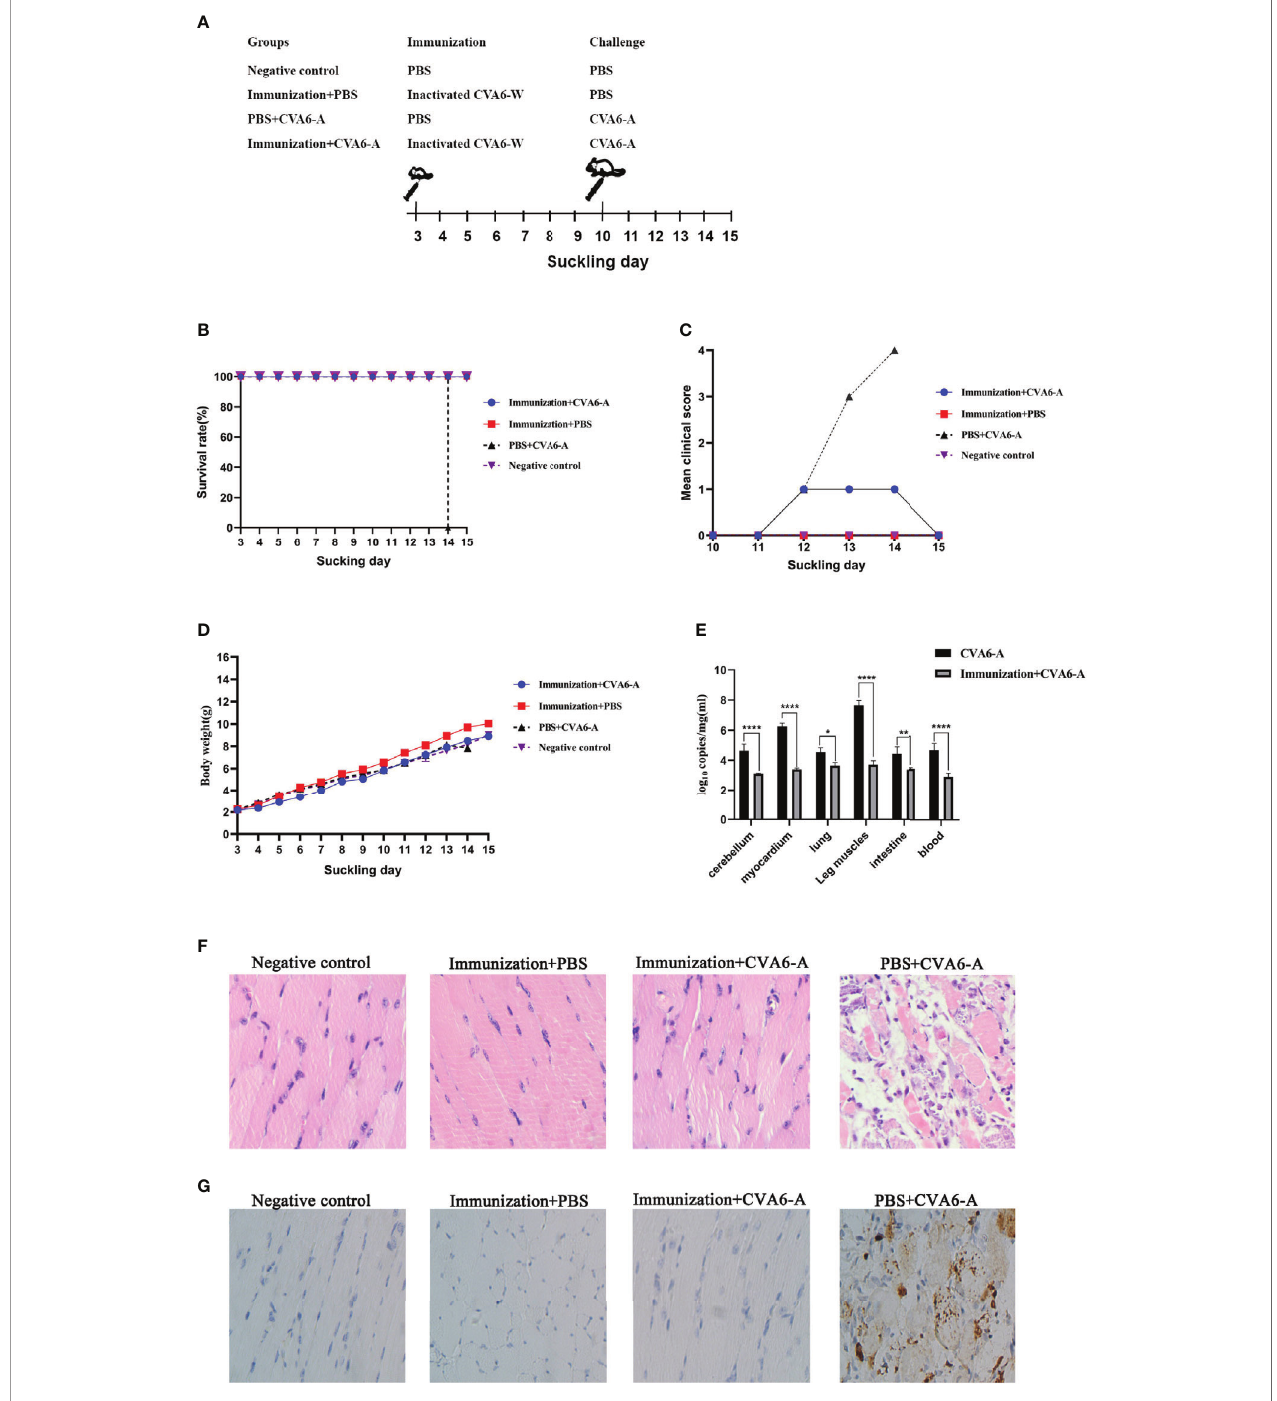
FIGURE 6 | Immunization and challenge of young suckling mice. (A) The diagram of the 10-day-old suckling mice challenged with coxsackievirus A6 (CVA6)-A pre- immunization, using inactivated CVA6-W. Two out of four groups of three-day-old mice (5 per group) were immunized with inactivated CVA6-W, while the other two groups were inoculated with PBS. As above, the survival rates, body weights, and the clinical scores were detected daily (B – D) after the challenge. The viral load in mice cerebellum, myocardium, lung, leg muscles, intestine, and the blood samples of the mice were detected by using qPCR (E) . (F) The histopathological and (G) immunohistochemical examinations of the tissues of the leg muscle of the challenged mice that were pre-immunized with CV6-A or PBS. All slice results were observed under 200×. *p < 0.05, **p < 0.01, ****p <